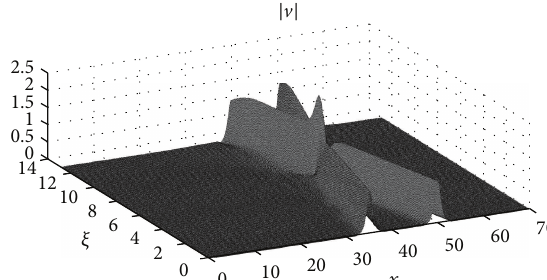
𝐴 = 10 . Observe that the intensity of the extrainhomoge- neous nonlinearities in system (1), produced by the coefficient 𝑒(𝑥) , affect significantly the amplitude of the vector soliton obtained.